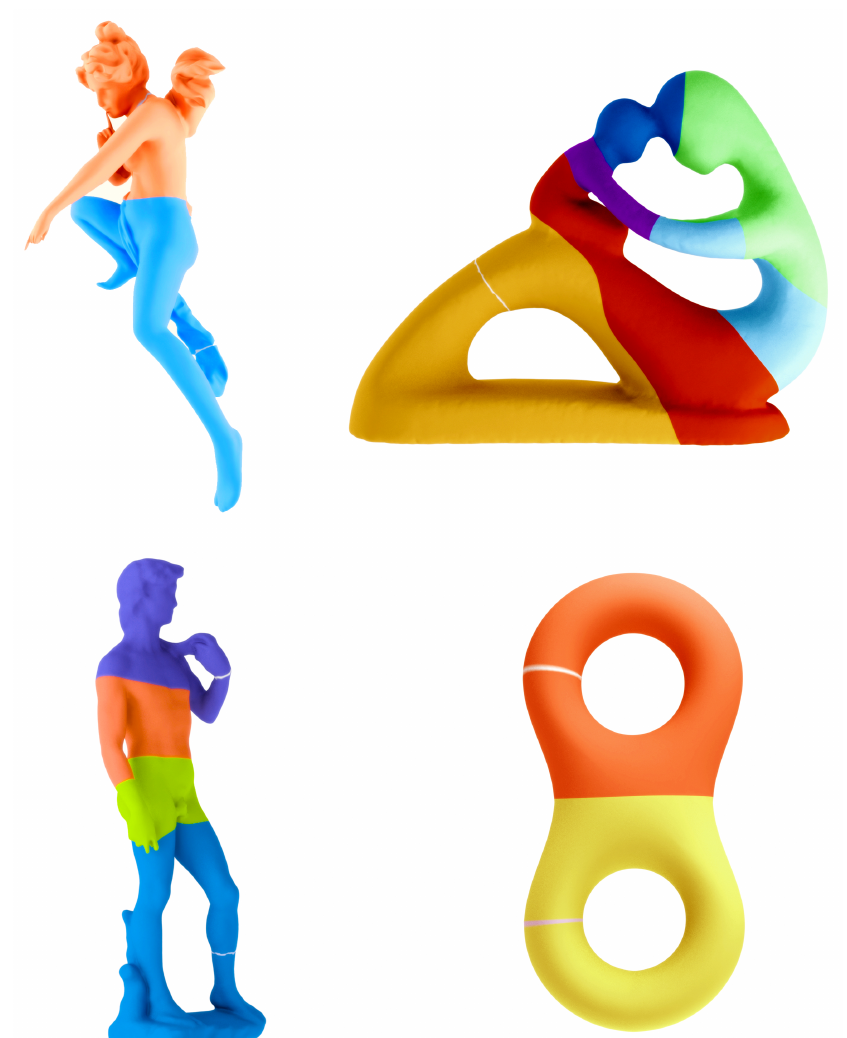
Figure 23. Examples of segmentation of higher genus surfaces into a pair of pants using our Reeb graph